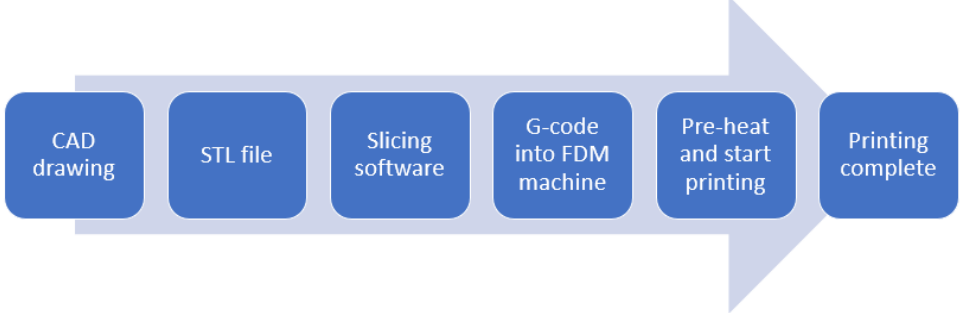
Figure 5. The 3D printer process from drawing to fused deposition .